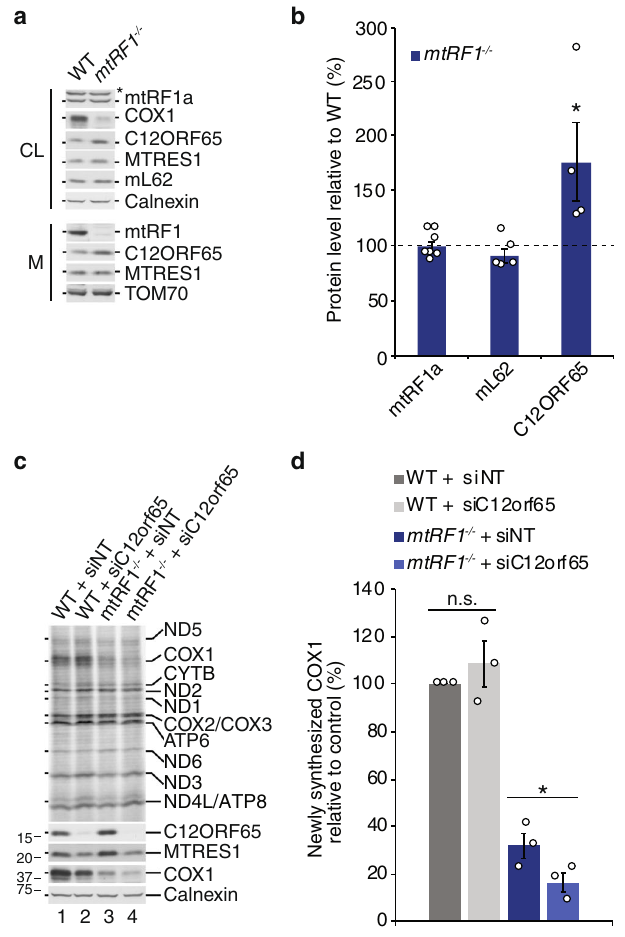
Fig. 5 | Loss of mtRF1 activates C12ORF65. a , b C12ORF65 protein levels are elevated in mtRF1-de fi cient cells. Whole cell lysates (CL, 25 µ g or 50 µ g) or isolated mitochondria (M, 75 µ g) were analyzed by western blotting using the indicated antibodies. Protein levels were quanti fi ed and calculated relative to the wild-type control (WT; dashed line; 100%) and individual data points are shown as circles. Statistical analysis was performed as two-sample one-tailed Student ’ s t -test with n ≥ 4 biologically independent samples shown as mean±SEM. Signi fi cance was de fi ned as * p ≤ 0.05. Asterisk in a indicates unspeci fi c signals. c , d Depletion of C12ORF65 in mtRF1 − / − further reduces COX1 levels. WT and mtRF1 − / − cells were transfected with siNT or siC12orf65. After 3days mitochondrial protein synthesis was monitored as described in Fig. 3 and ef fi ciency of siRNA-mediated depletion was controlled by western blotting. Newly synthesized COX1 was quanti fi ed from three independent experiments shown as mean±SEM with individual data points indicated as circles. Statistical analysis was performed as two-sample one-tailed Student ’ s t -test and signi fi cance was de fi ned as * p ≤ 0.05 and p >0.05 as not sig- ni fi cant (n.s.). Source data are provided as a Source Data fi